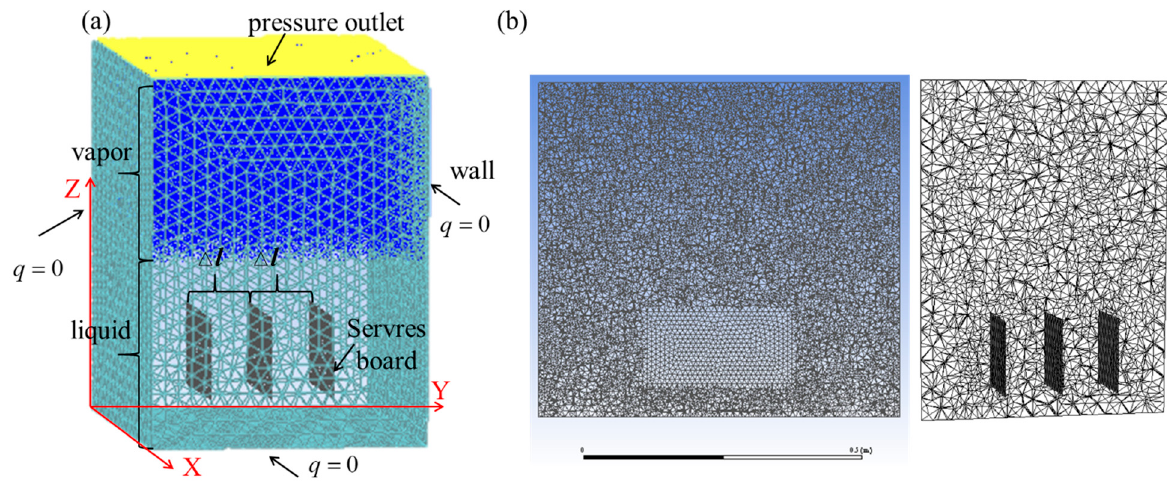
Figure 3. Models for the tank and servers. ( a ) Mesh of the model ( b ) Grid section.